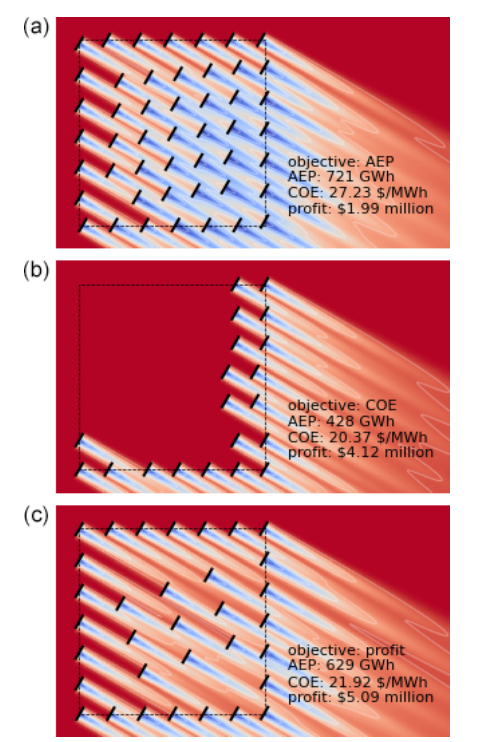
Figure 9. The optimal layouts for each objective for the large wind power plant with a unidirectional wind rose. From top to bottom, the associated objective functions are AEP, COE, and profit. The text within each figure provides the value of all three metrics for each wind